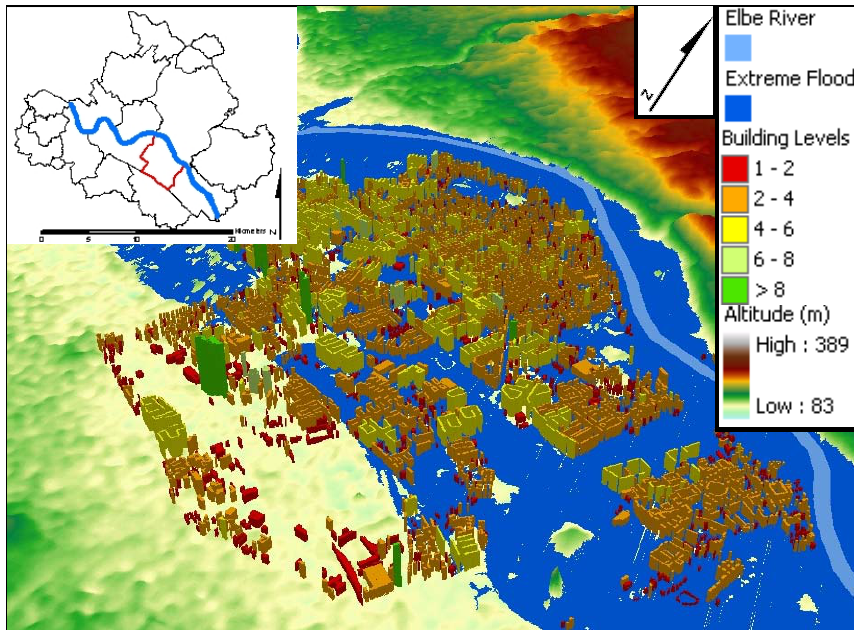
Fig. 4: Overlapping of flood scenario (EHQ) with structures of the city of Dresden. Fig. 4. Overlapping of flood scenario (EHQ) with structures of the city of The height information in the ALS data, with a geometric resolution of 1 meter, makes it possible to delineate neat building boundaries in the first place and to enhance them with three-dimensional in- formation in the second place. This leads to a proper representation of the urban fabric in terms of a 3-